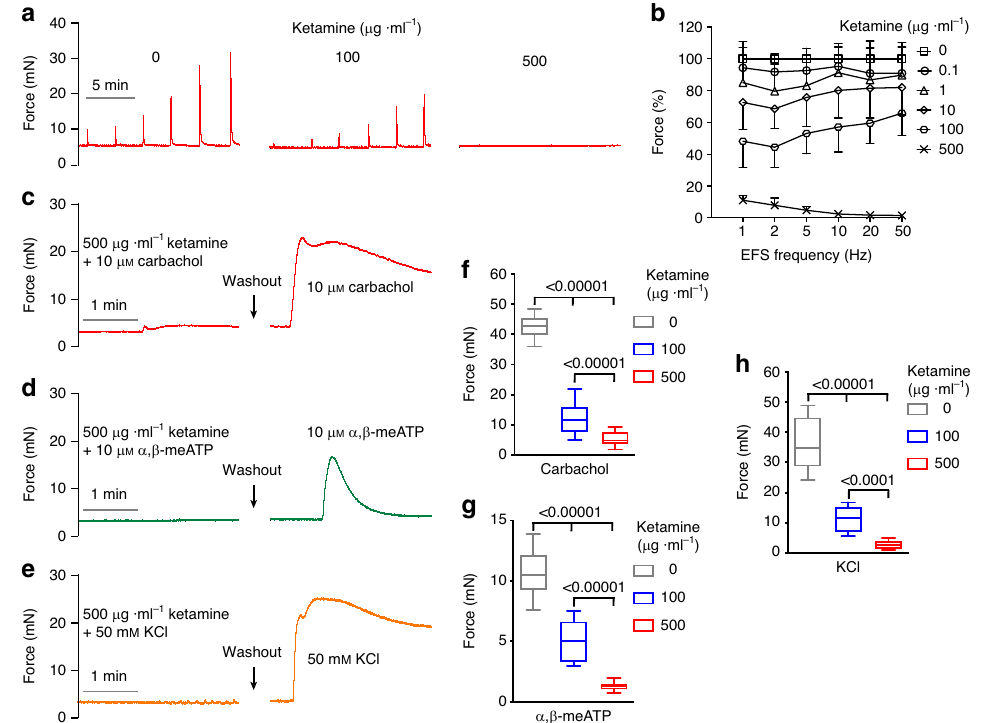
Fig. 1 Ketamine inhibits BSM contraction. a Representative traces of mouse BSM contraction in response to EFS (1, 2, 5, 10, 20, 50 Hz), showing dose- dependent inhibition by ketamine (0.1 – 500 µ g ml − 1 ). b Summarized data from experiments as in a ( n = 12 BSM strips). Data are presented as mean values ± SD. c – e Representative traces of mouse BSM treated fi rst with ketamine plus either carbachol ( c n = 14 BSM strips), α , β -meATP ( d n = 10 BSM strips), or 50 mM KCl ( e n = 11 BSM strips), followed by drug washout and subsequent re-exposure to the indicated drugs in the absence of ketamine. f – h Summarized data from c – e . Data are shown as box and whiskers, center line is the median of the data set, box represents 75% of the data, and bars indicates whiskers from minimum to maximum. Data were analysed by one-way ANOVA with Bonferroni ’ s posthoc tests. P < 0.05 is considered to be signi fi cant and P values are given above the bars. Source data are provided as a Source Data fi le.